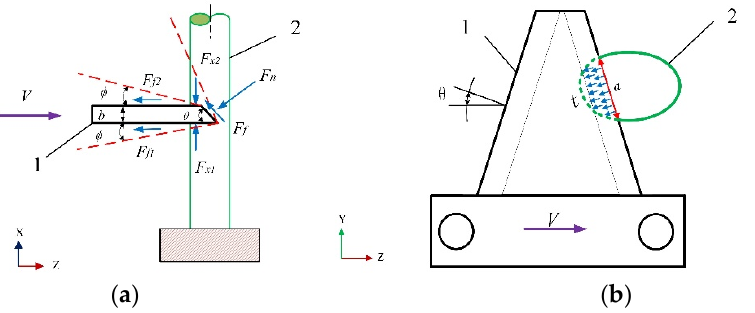
Figure 3. Cutting force diagram of the cutting blade. ( a ) Cutting force diagram in XZ-plan; ( b ) Cutting force diagram in YZ-plan; 1. Cutting blade; 2. Stem.